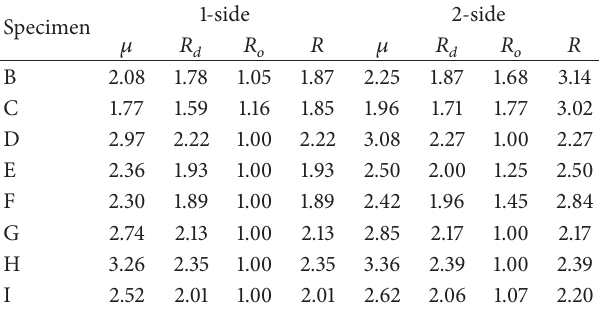
Table 9: The evaluated seismic parameters of braced walls.